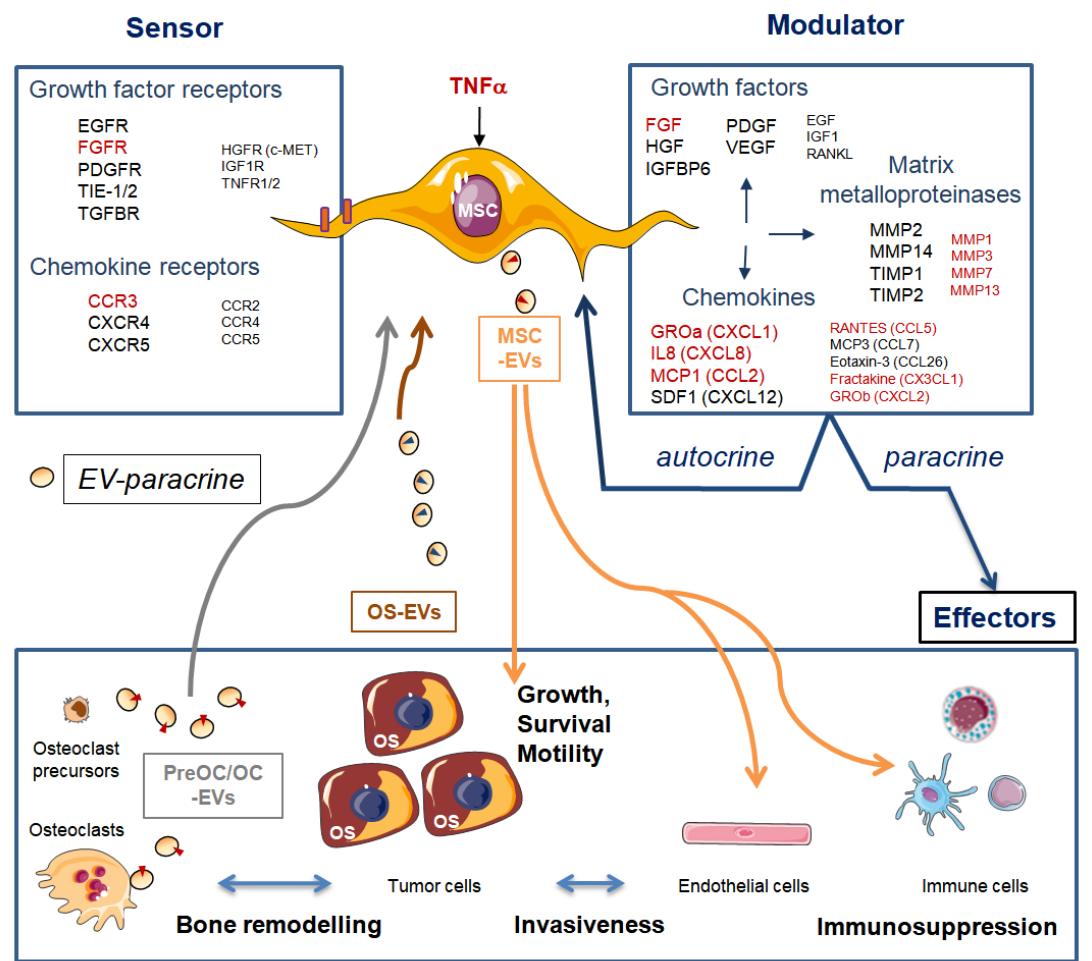
Figure 5. Sensing and modulating roles of mesenchymal stem / stromal cells (MSCs). MSCs constitutively express many mitogenic growth factors, chemokines, and matrix metalloproteinases at various levels. High / intermediate and low levels are represented by large or small font size, respectively. MSCs respond to tumor necrosis factor alpha (TNF α ) by increasing expression (indicated in red) of some growth factor receptors (GFR), growth factors (GF), chemokine receptors (CR), chemokines, interleukins (IL), and matrix metalloproteinases (MMP) [61]. MSCs have autocrine and paracrine trophic properties, as all of these growth factors are able to act on several e ff ectors of the tumor ecosystem (tumor, bone cells, endothelial cells, and immune cells). MSCs can also secrete extracellular vesicles (EVs) that convey diverse contents (see text for details), and they can receive information through EVs from bone pre-osteoclasts (pre-OC) and osteoclasts (OC) and tumor cells. EGFR: epithelial GFR; VEGFR: vascular endothelial GFR; TIE-1: angiopoietin receptor; TGFBR: transforming growth factor beta receptor; TIMP: tissue inhibitors of MMP; CXCL: chemokine (C-X-C motif) ligand; CCL: chemokine (C-C motif) ligand; GRO α / β : growth-regulated oncogene alpha / beta (also known as CXCL1 / 2); MCP1 / 3: monocyte chemoattractant protein (also known as CCL2 / 7); SDF1: stromal cell-derived factor (also known as CXCL12); RANTES: Regulated on Activation Normal T Cell Expressed and Secreted (alias CCL5). Gebraad et al. isolated EVs from lipopolysaccharide-activated monocytes and RANKL-activated osteoclasts, both EVs bearing RANK, and observed EV e ff ects on gene expression and protein